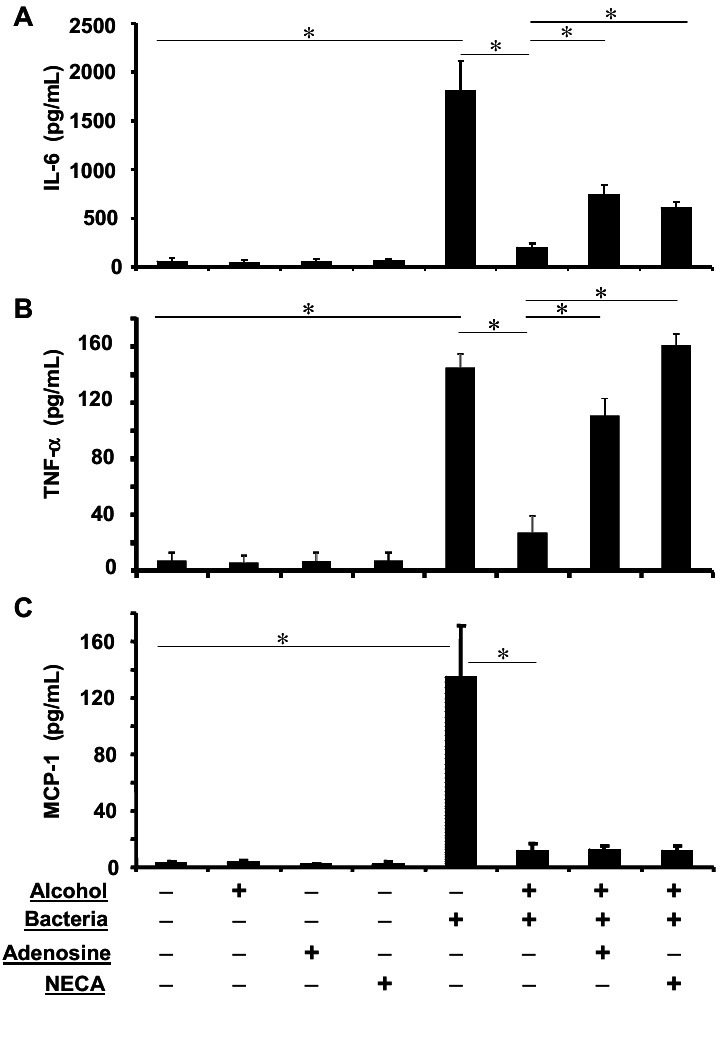
Figure 6. Adenosine receptor agonists partially restore alcohol-suppressed cytokines. Polarized epithelia were exposed to 0 or 50 mM of alcohol basolaterally and challenged with K. pneumoniae apically in presence of adenosine (100 µM) or NECA (10 µM). Bacterial challenge significantly elevated IL-6, TNF- α , and MCP-1 release. Alcohol blunted such an increase. ( A ) Adenosine and NECA partially restored the alcohol-suppressed IL-6; ( B ) Adenosine and NECA almost completely restored the alcohol-suppressed TNF- α ; ( C ) Adenosine and NECA had no effect on the alcohol-suppressed MCP-1. Asterisks denote statistically significant difference ( p ≤ 0.05, n =